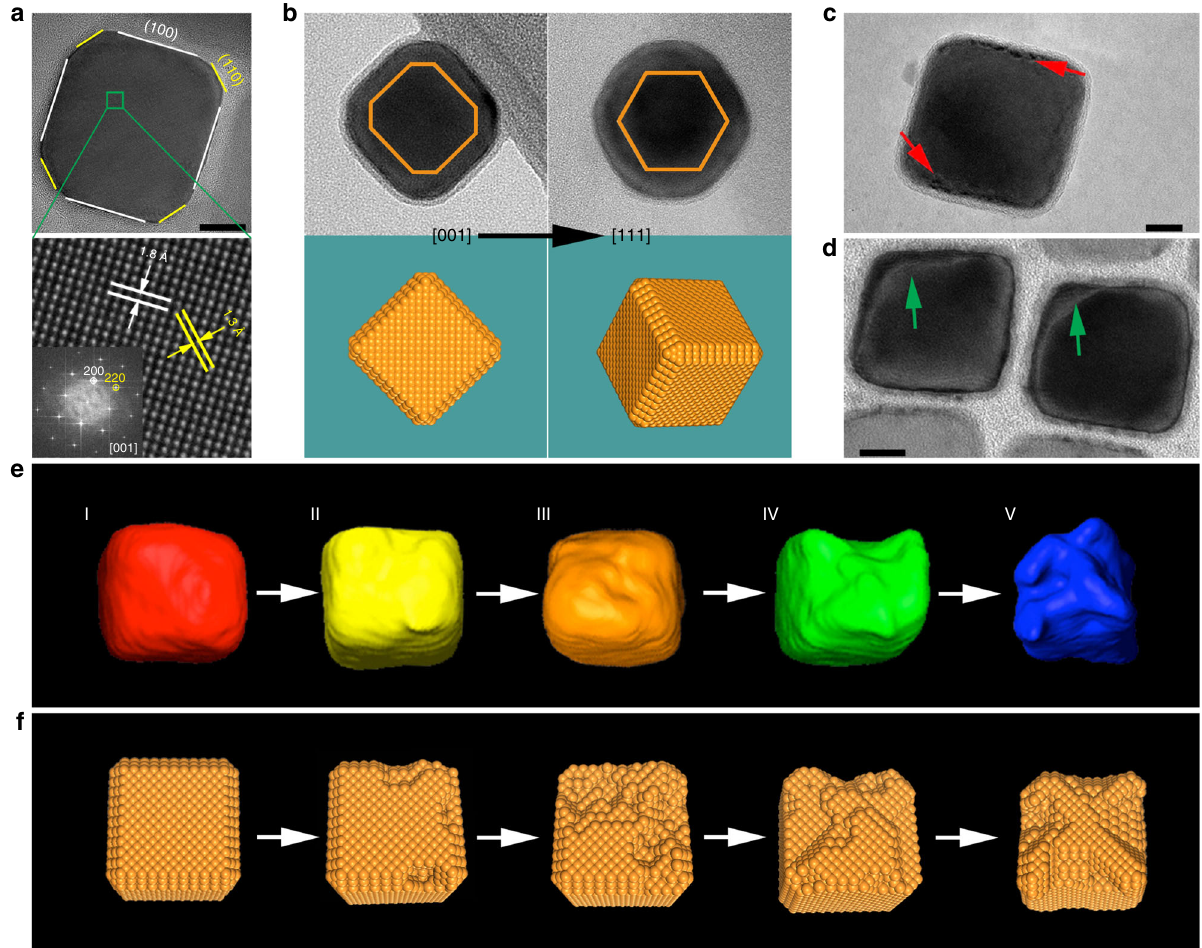
Fig. 4 Crystalline facets and degradation pathway. a Top, HR-TEM image of one 41 nm CuNC along the [001] crystallographic direction; Bottom, an enlarged view of the region marked in the top panel. The inset shows the fast Fourier transformation (FFT) of the HR-TEM image. b TEM images and corresponding morphological models of one CuNC along two crystallographic directions, [001] and [111], from left to right. c , d TEM image of one CuNC electrolyzed for c 1 h and d 3 h. The arrows point to the positions where the degradations take place. e Tomographic reconstruction of the CuNCs and f corresponding schematic morphological models at different stages during a 12 h-course of CO 2 RR. Scale bars: 10